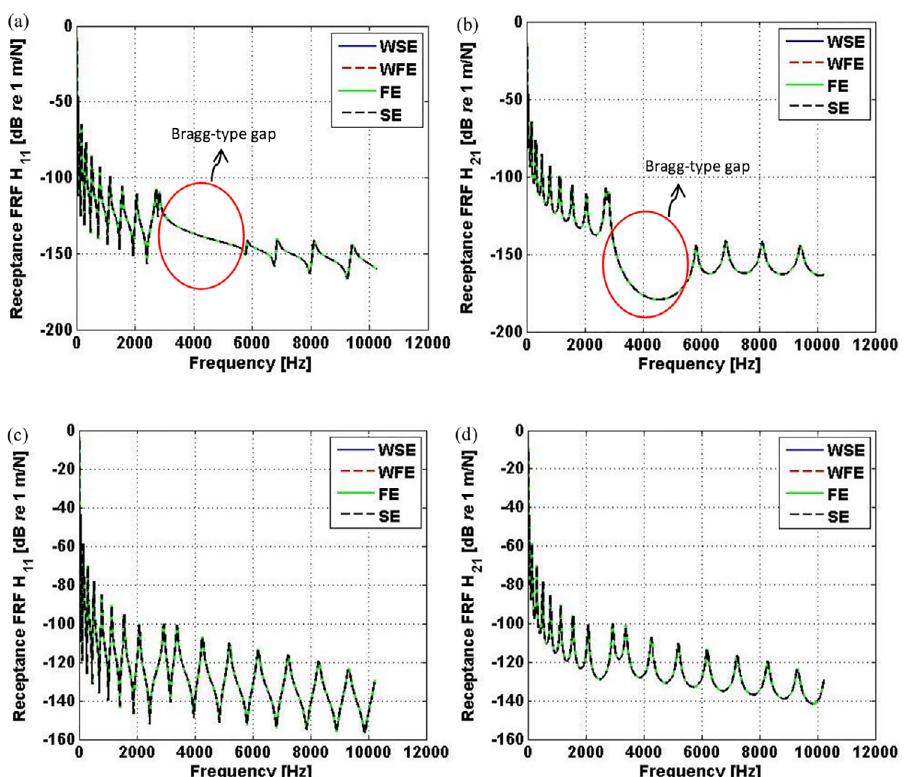
Figure 3. Point receptance (a-c) and transfer receptance (b-d) of the PC beam calculated by WSE, WFE, FE and SE methods, considering models 1 (a-b) and 2